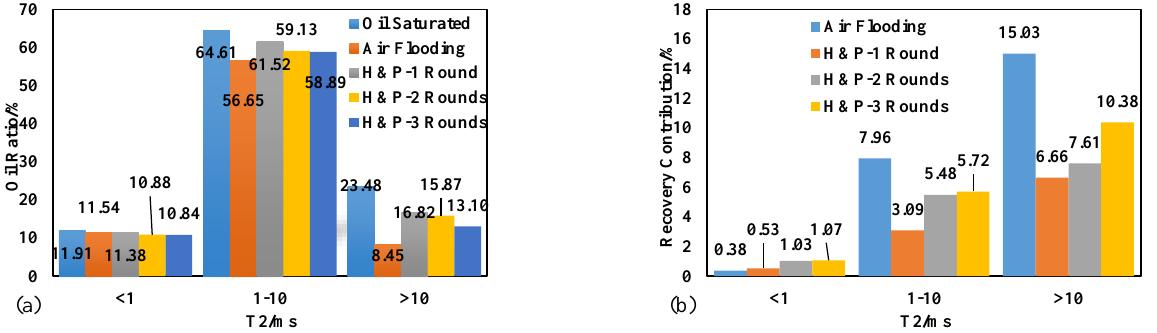
Figure 9. Distribution of oil in different grades of pores ( a ) and their contribution to recovery factor ( b ).